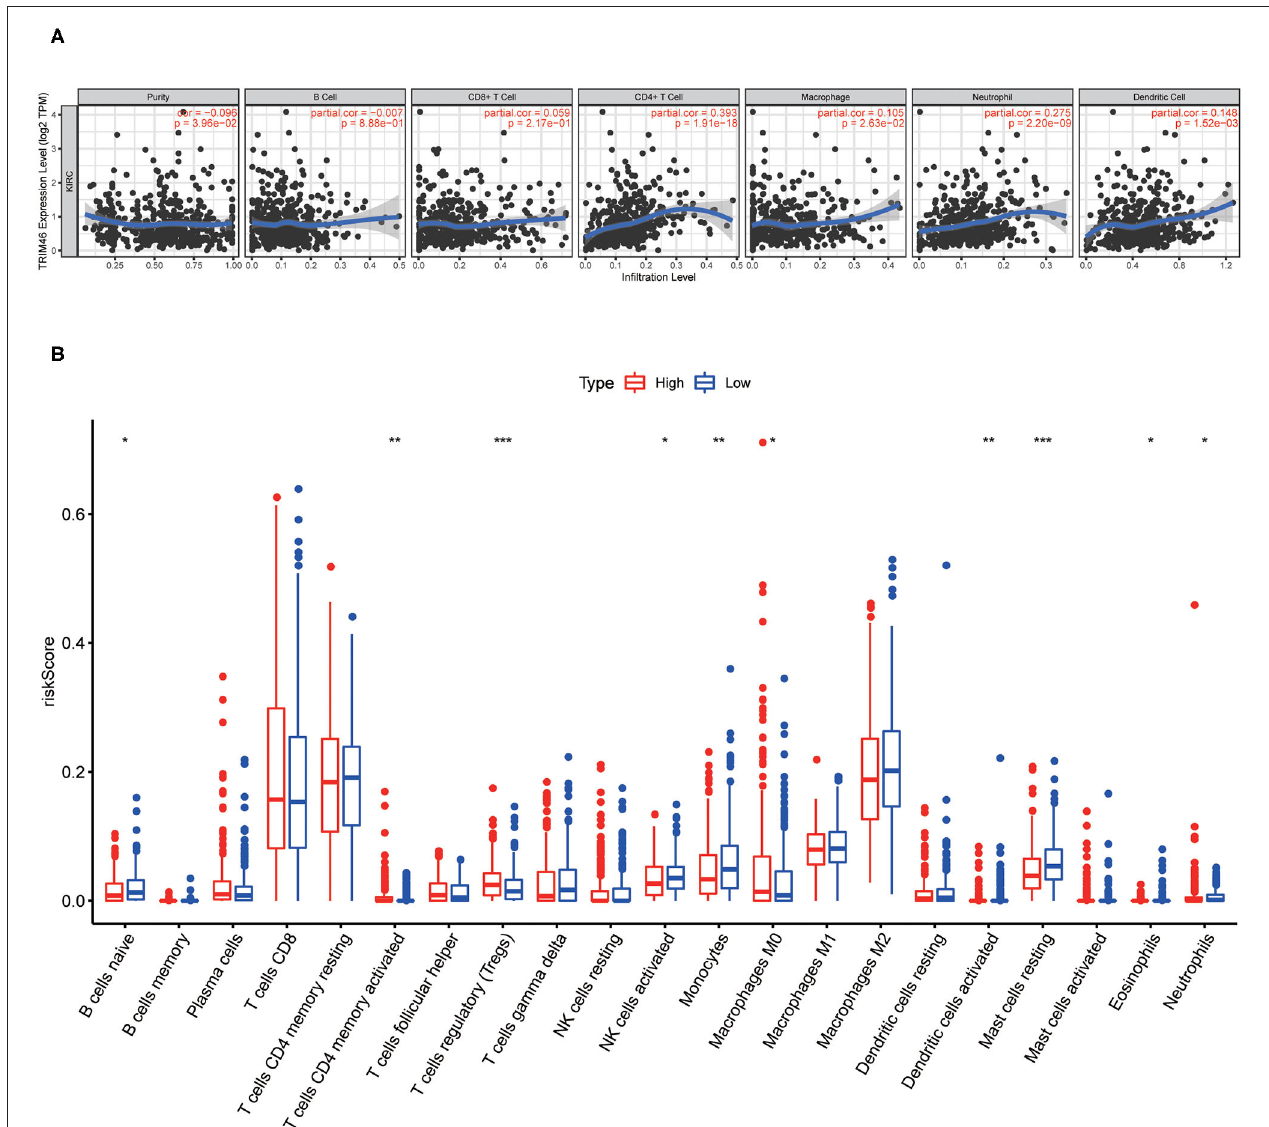
FIGURE 9 | Associations of tumor-infiltrating immune cell (TIIC) proportion with TRIM46 expressions. (A) Six immune cell infiltration levels were involved in the expressions of TRIM46 in in ccRCC (TIMER database); (B) barplot of the proportion of 21 kinds of TIICs in ccRCC specimens (* p < 0.05, ** p < 0.01, *** p <